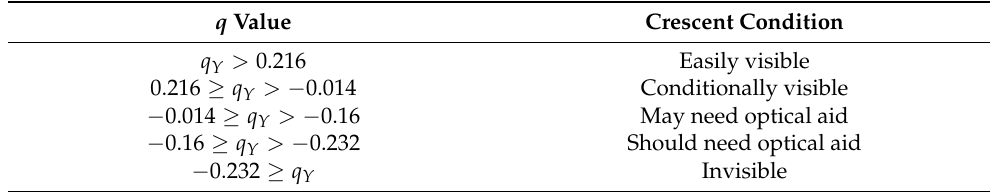
Table 2. Crescent Conditions for Yallop’s criterion [16]. q Value Crescent Condition q Y > 0.216